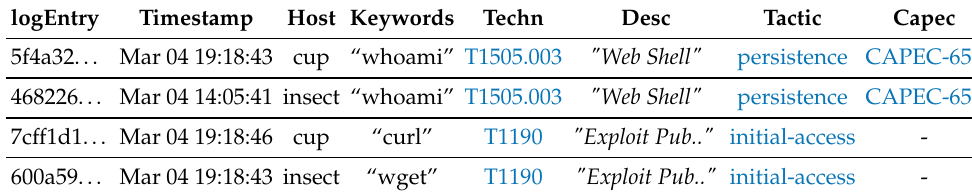
Figure 10. Threat detection and ATT&CK linking visualization (excerpt). Table 3. Scenario 4 Query Results